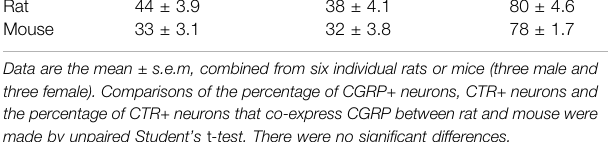
immunoreactive band at ~52 kDa and a weaker band at ~110 kDa.